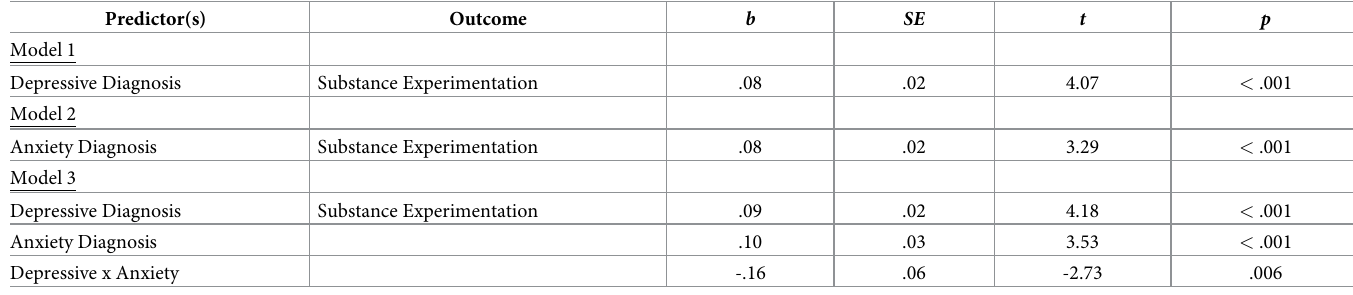
Table 2. Three models examining affective diagnostic status as a predictor of generalized substance experimentation.